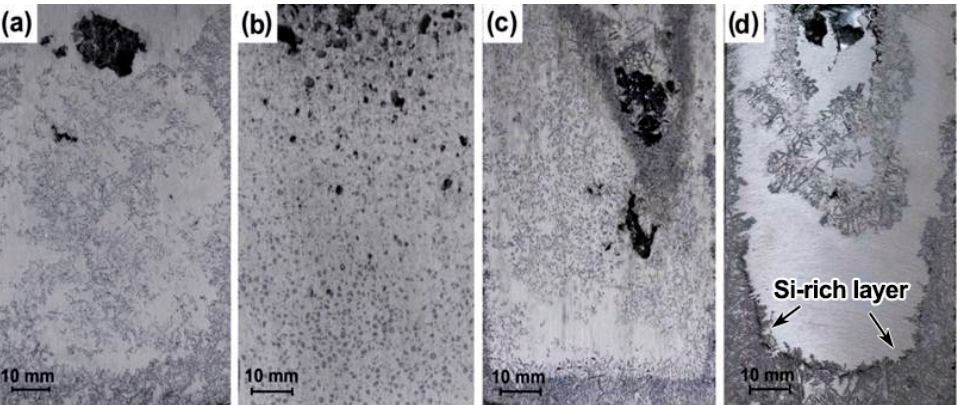
Figure 5. Vertical-sections of Al-30Si alloys solidified under coupling action of a temperature field and an electromagnetic field: ( a ) C II -1, ( b ) C II -2, ( c ) C II -3, ( d ) C II -4.